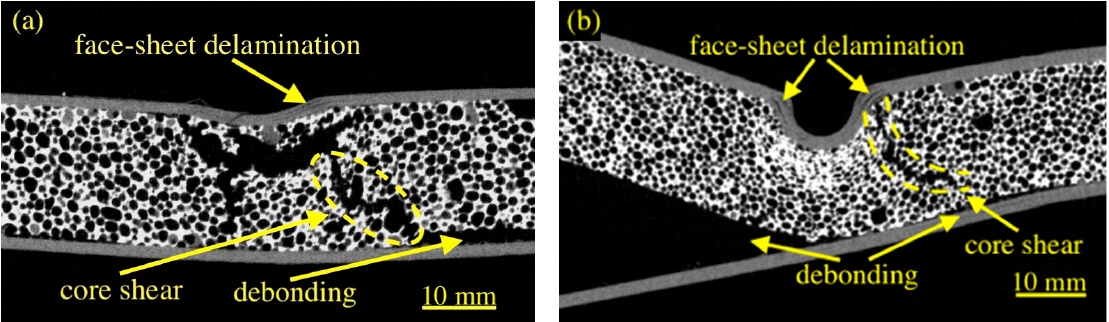
Figure 13. Tomographic images: ( a ) #20-0.57; ( b ) #20-0.75.